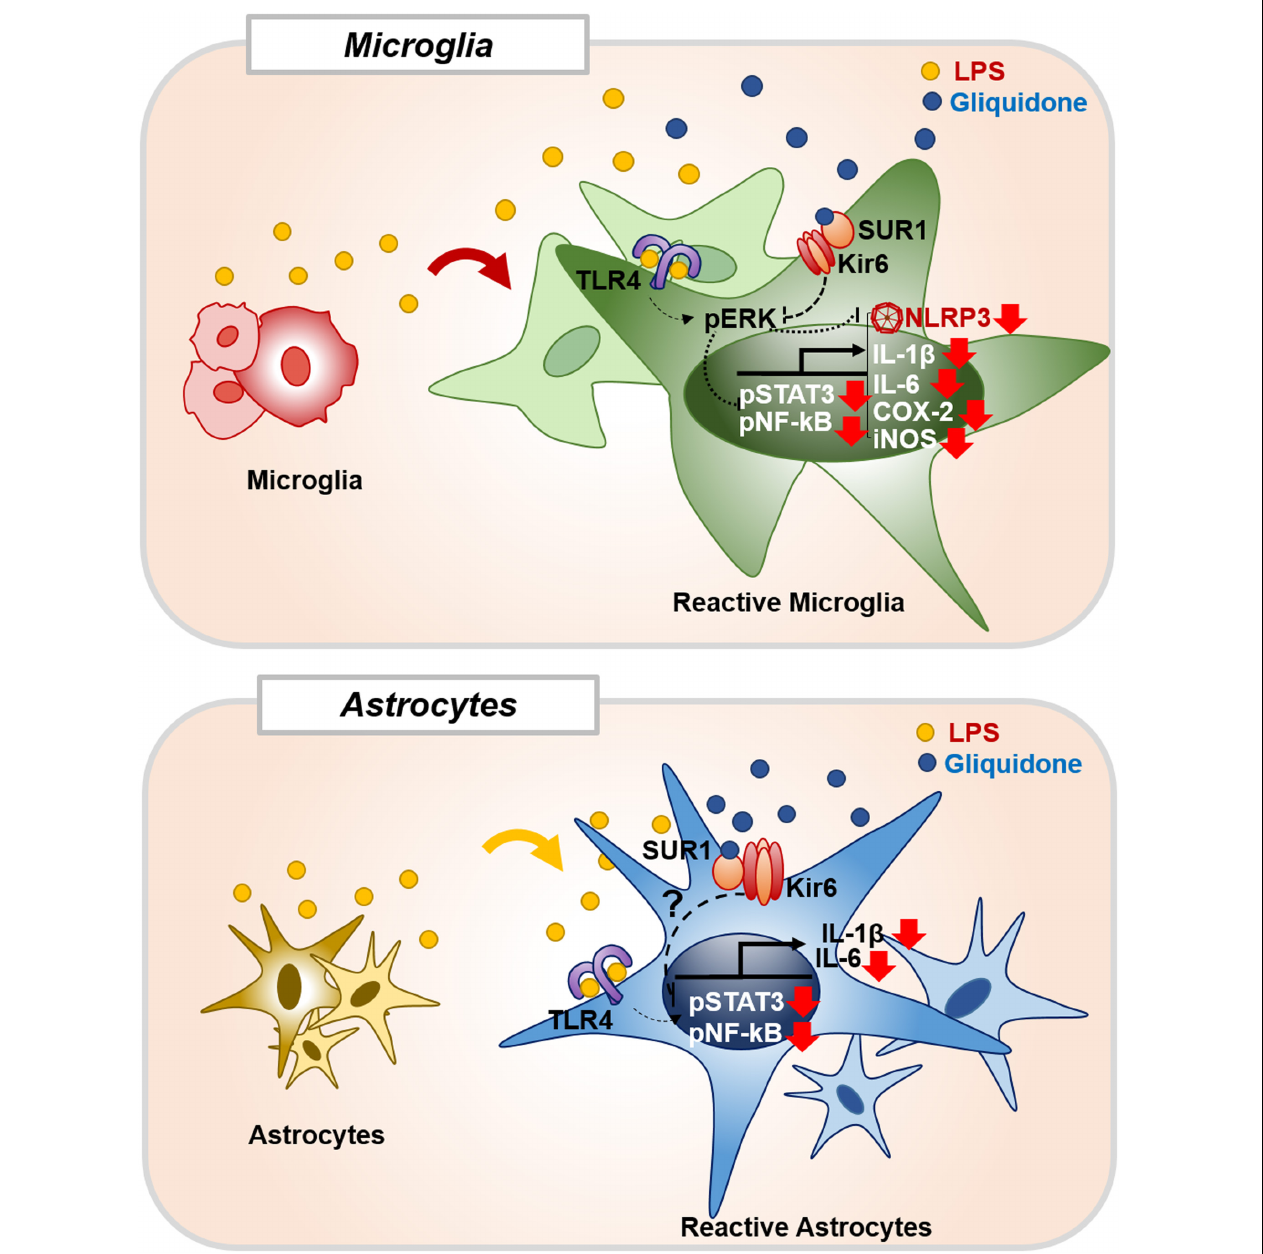
FIGURE 11 | Gliquidone affects LPS-stimulated neuroinflammatory responses in vitro and in vivo . In BV2 microglial cells and wild-type mice, gliquidone reduces LPS-stimulated microglial proinflammatory cytokine expression by modulating ERK-associated STAT3/NF- κ B signaling in an NLRP3-dependent manner. In primary astrocytes, gliquidone selectively downregulates LPS-induced astrocytic proinflammatory cytokine expression by decreasing STAT3/NF- κ B phosphorylation via an NLRP3-independent pathway. Accordingly, gliquidone may have therapeutic potential for neuroinflammation-related neurodegenerative